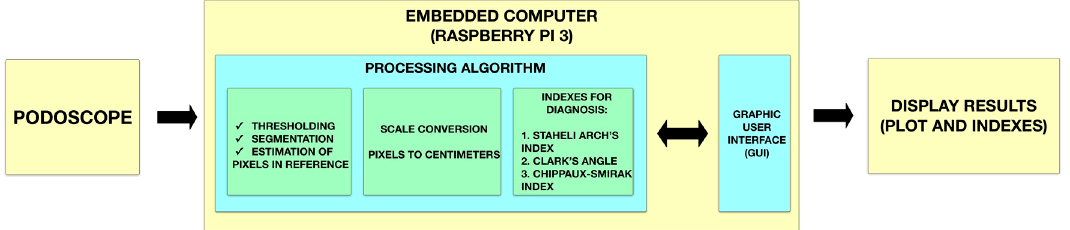
Figure 3. Block diagram of the smart sensor.